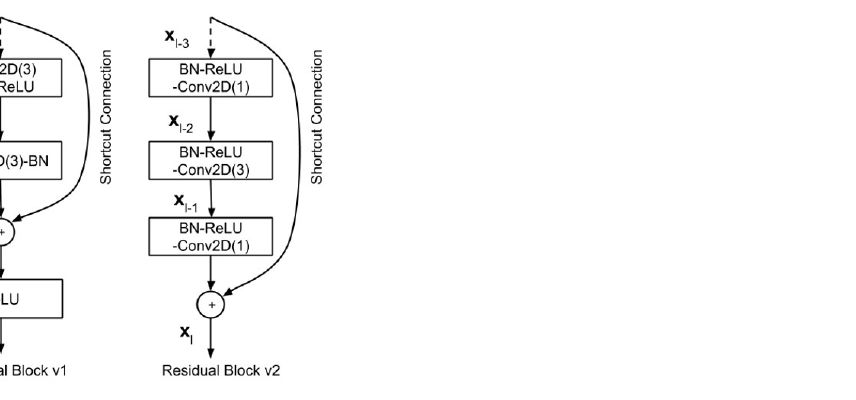
Figure 9. A comparison of residual blocks between ResNet v1 and ResNet v2